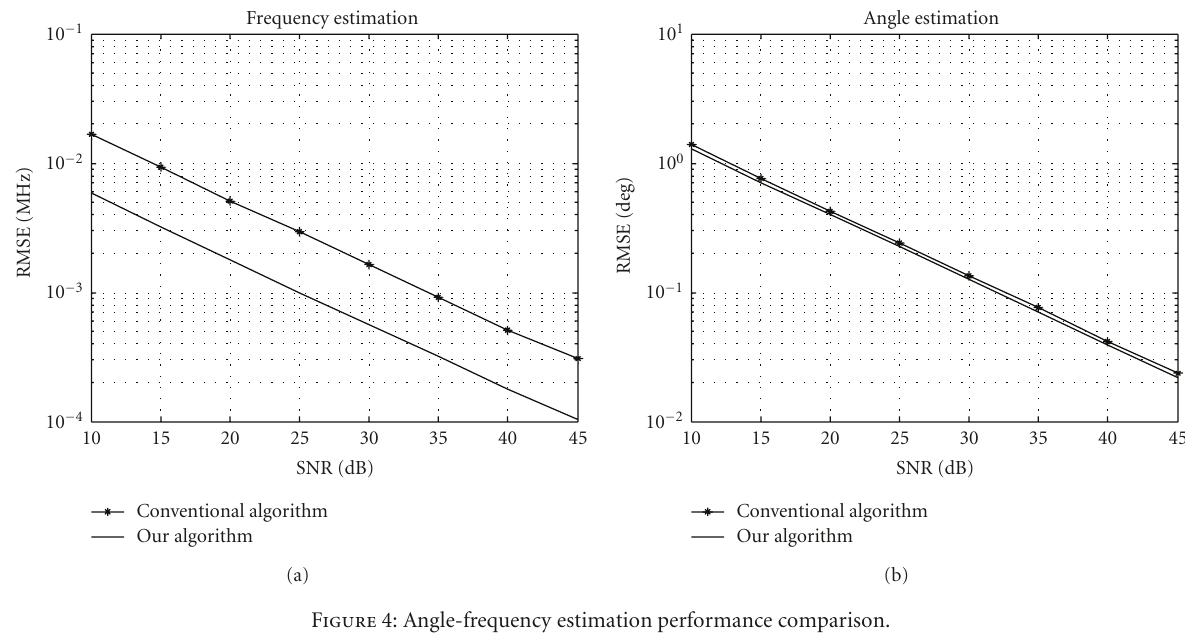
Figure 4: Angle-frequency estimation performance